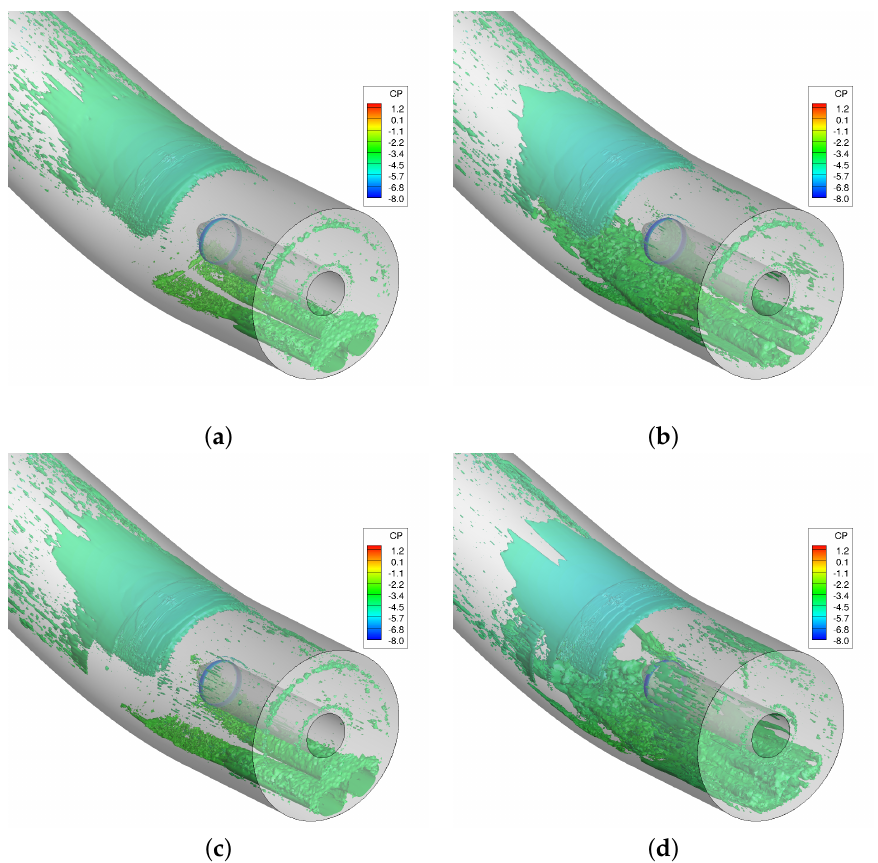
Figure 12. Isosurfaces of scale Q-criterion (iso value of 0.25) colored by pressure coefficient. NASA baseline grid was used. CFD data are time-averaged from 2 to 2.5 s of simulation time. ( a ) SARC turbulence